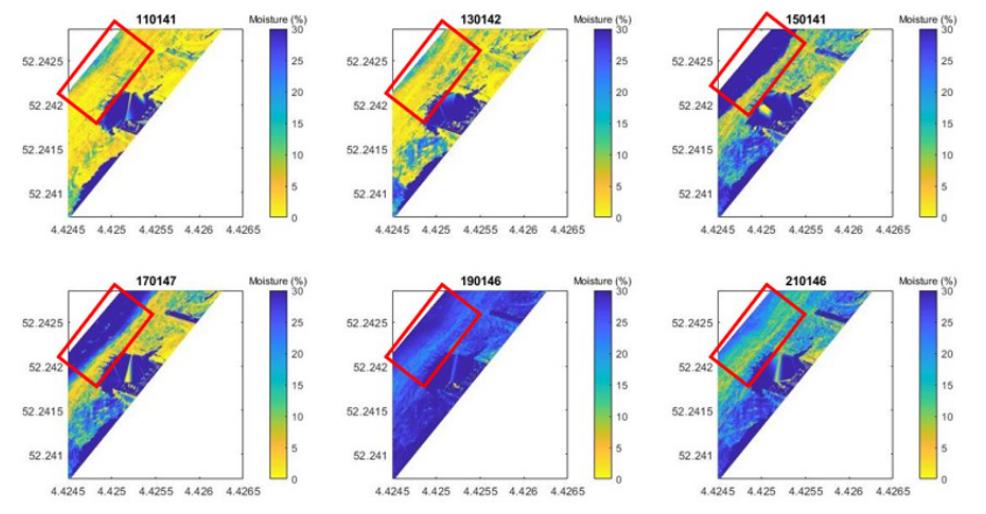
Figure 11. Selection of moisture maps evaluated on 12 October 2019. For each image, the time is reported on top as HHMMSS. The area of interest is shown in the red rectangle. Both the tidal condi- tion (increasing tide until 15:01, then decreasing) and the increasing precipitation rate (maximum value at 19:01) can be seen in the masks. The top three images are characterized by the absence of rain and an increasing tidal condition. The image at 15:01:41 represents the highest tidal condition, where part of the beach area is covered by seawater and the moisture reaches the saturation value (30%). After that, the moisture starts decreasing again with the lowering of the tide. The lower images show the increasing precipitation rate: The moisture value of the sandy area that is not affected by the tide, which used to be in the range of 0–5%, increases to 10–15% at 19:01:46, when the precipitation rate is the highest. At 21:01:46, the moisture values are lower